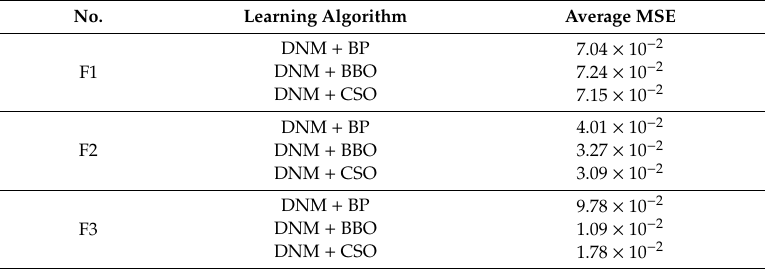
Table 16. Average MSE at end condition.